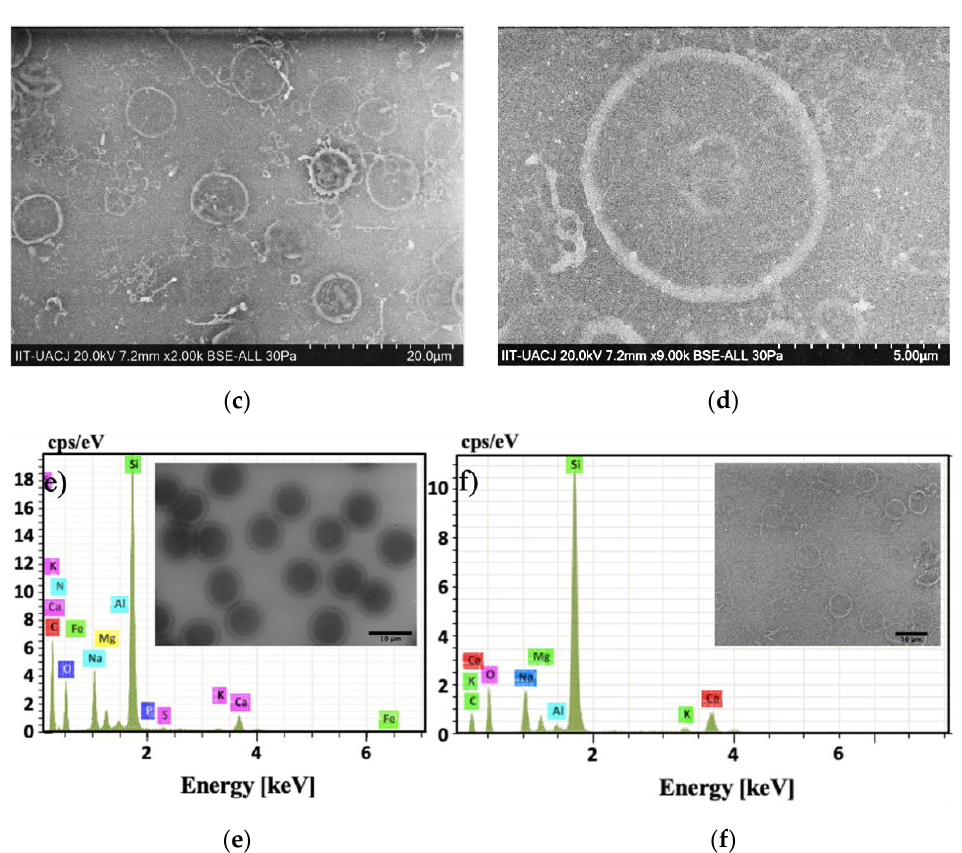
Figure 13. SEM micrographs of: ( a , b ) red blood cell, ( c , d ) ghost erythrocyte membranes, ( e ) EDS analysis of red blood cells and ( f ) EDS analysis of erythrocyte ghost.